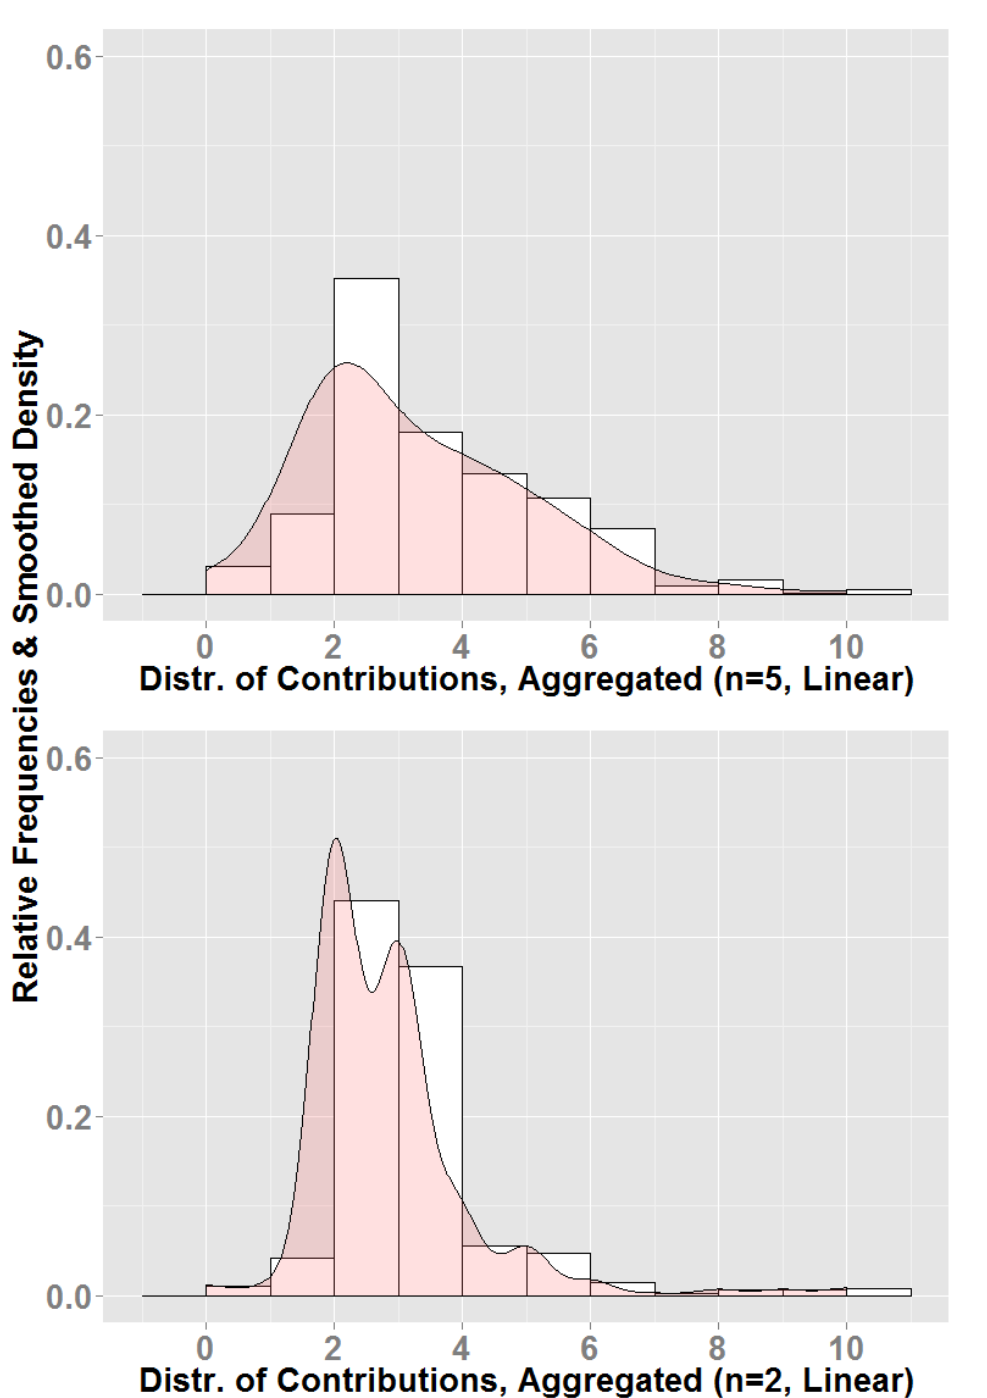
Figure 4. Distribution of average contribution, linear SCF; upper panel: n = 5, lower panel: n = 2. In Figure 5, the blue line depicts the time path of the contributions averaged over all subjects ( n = 40) each period in the linear treatment with five players. The red line shows the respective average contributions when the group size is two, and the dominant equilibrium contribution level is marked with a black horizontal